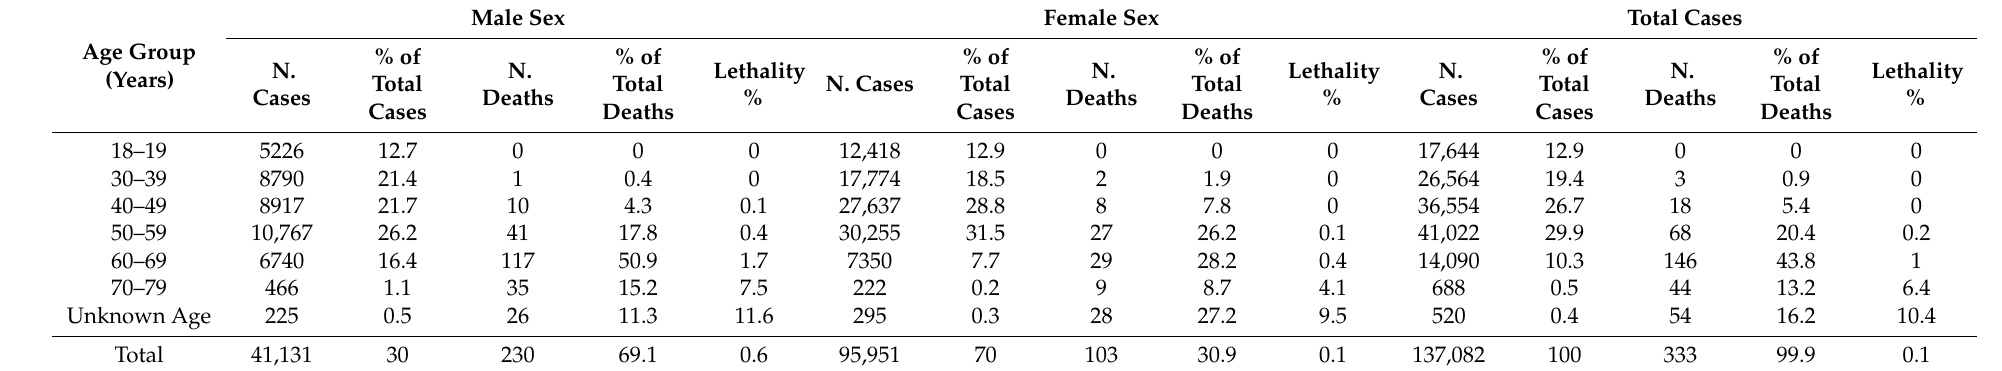
Table 2. Distribution of cases ( N = 137,082) and healthcare workers COVID-19 related deaths in Italy ( N = 333) stratified by age group and sex (produced by the Istituto Superiore di Sanit à (ISS), Rome. Data updated to 14 July